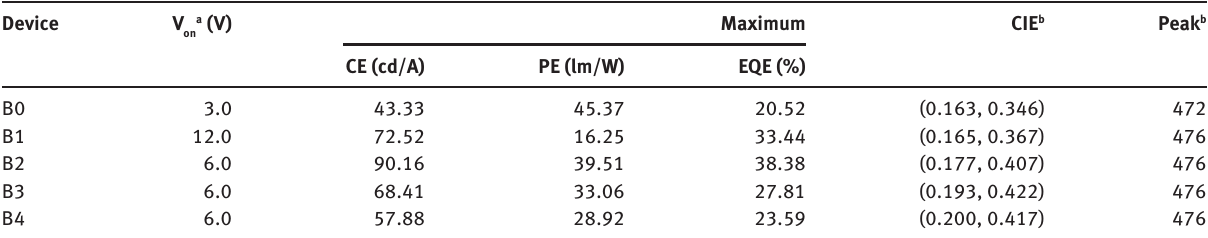
Table 1: The EL performance parameters summary of all blue OLEDs involved in this paper. Device V ona